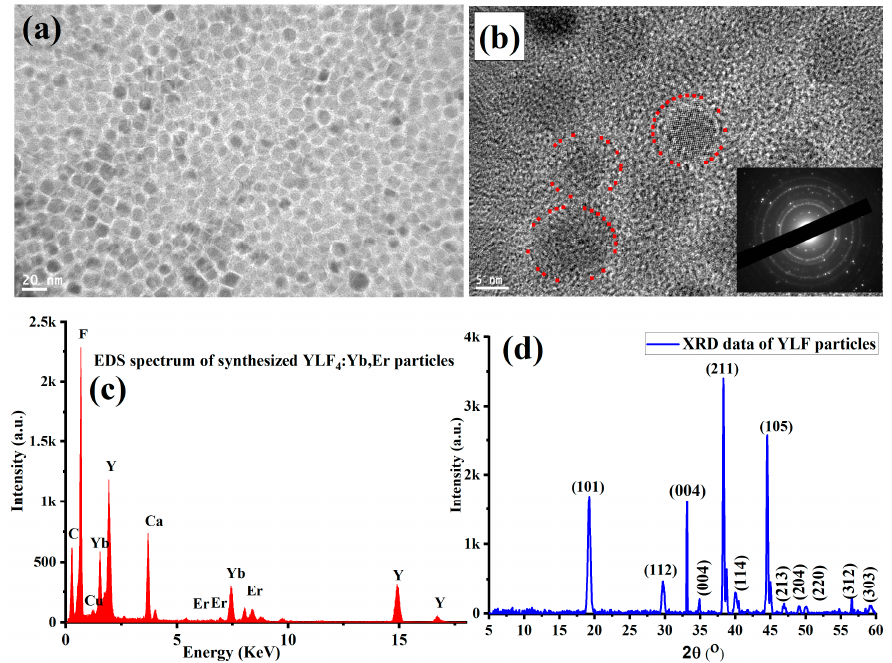
Figure 1. Characterizations of the synthesized YLiF 4 :Yb,Er UCNPs. ( a ) Low magnification TEM image of the synthesized UCNPs showing ultrasmall (less than 15 nm) and well-dispersed nanoparticles. ( b ) High magnification image of the syn- thesized UCNPs showing crystalline UCNPs. ( c ) Energy-dispersive X-ray (EDX) spectrum for the elemental analysis of the synthesized UCNPs. ( d ) XRD pattern of UCNPs with relatively sharp peaks for crystalline, high-quality particles. The UCNPs were introduced into the PSCs device in the mesoporous layer at differ- ent mixing ratios with TiO 2 nanoparticles, as detailed in Section 2. The goal was to convert the NIR bands of the solar spectrum into a visible light, which can be harvested by the perovskite active layer, as illustrated in Figure 2a. To fully utilize this strategy, it was im- portant to carefully choose an upconverting ion of the rare earth elements with perfect matching emission to the perovskite light-harvesting absorption band. One of the best candidates was erbium (Er +3 ), which emits an intense green and red light within the visible range of the perovskite active absorption, as illustrated in Figure 2b.